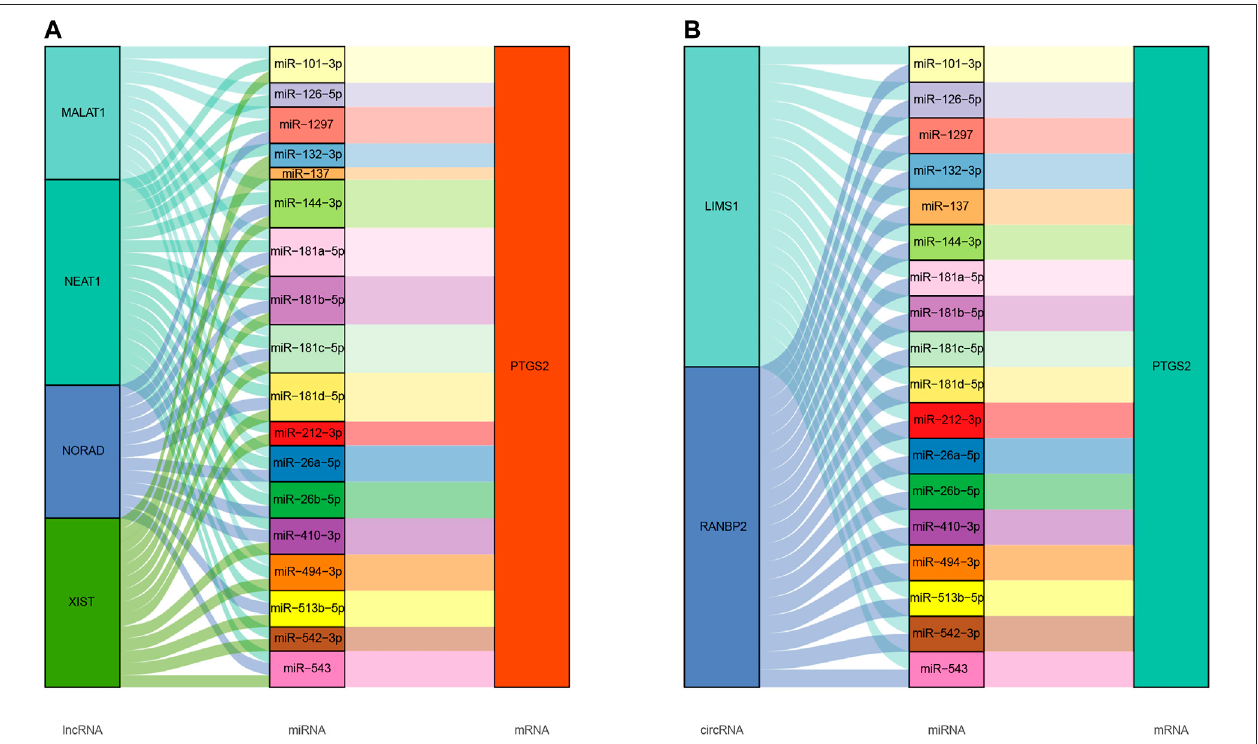
FIGURE 5 | (A) The lncRNA-miRNA-mRNA ceRNA Sankey plot was constructed via 4 lncRNAs, 18 miRNAs, and PTGS2 for SSc-ILD; (B) The circRNA-miRNA- mRNA ceRNA Sankey plot was constructed via 2 circRNAs, 18 miRNAs, and PTGS2 for SSc-ILD.